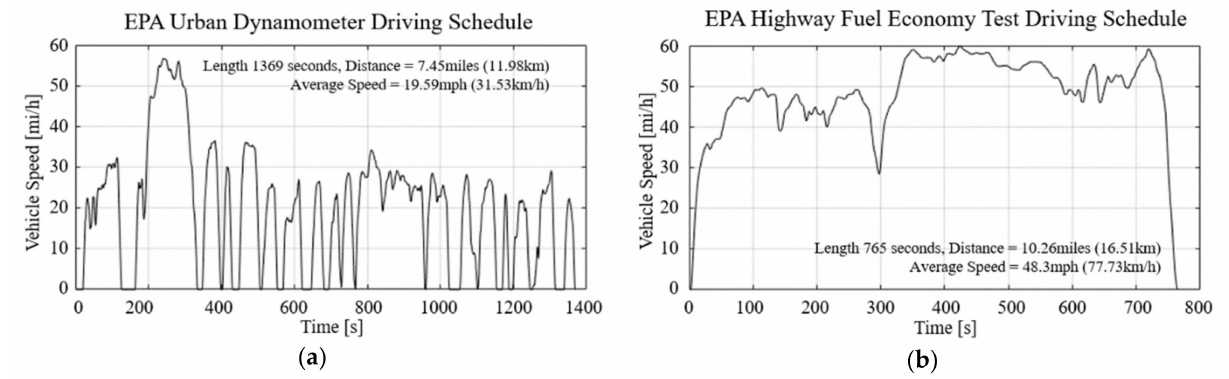
Figure 1. ( a ) Urban Dynamometer Driving Schedule (UDDS) and ( b ) Highway Fuel Economy Test (HWFET) driving